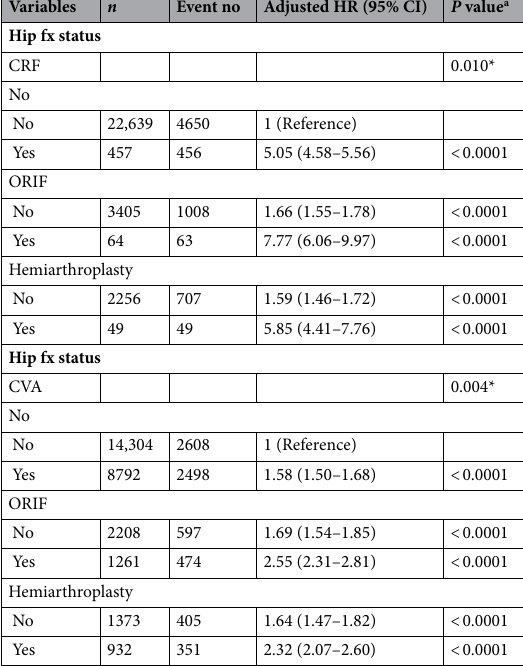
Table 4. Cox proportional hazard regression analysis for the risk of hip fx-associated S-UTI with interaction of CRF and CVA. Adjusted HR: adjusted for femoral neck fracture, sex, age, and the comorbidities in Cox proportional hazards regression. HR hazard ratio, CI confidence interval, CRF chronic renal failure, CVA cerebrovascular accident, fx fracture, ORIF open reduction and internal fixation, S-UTI severe urinary tract infection. a P value for